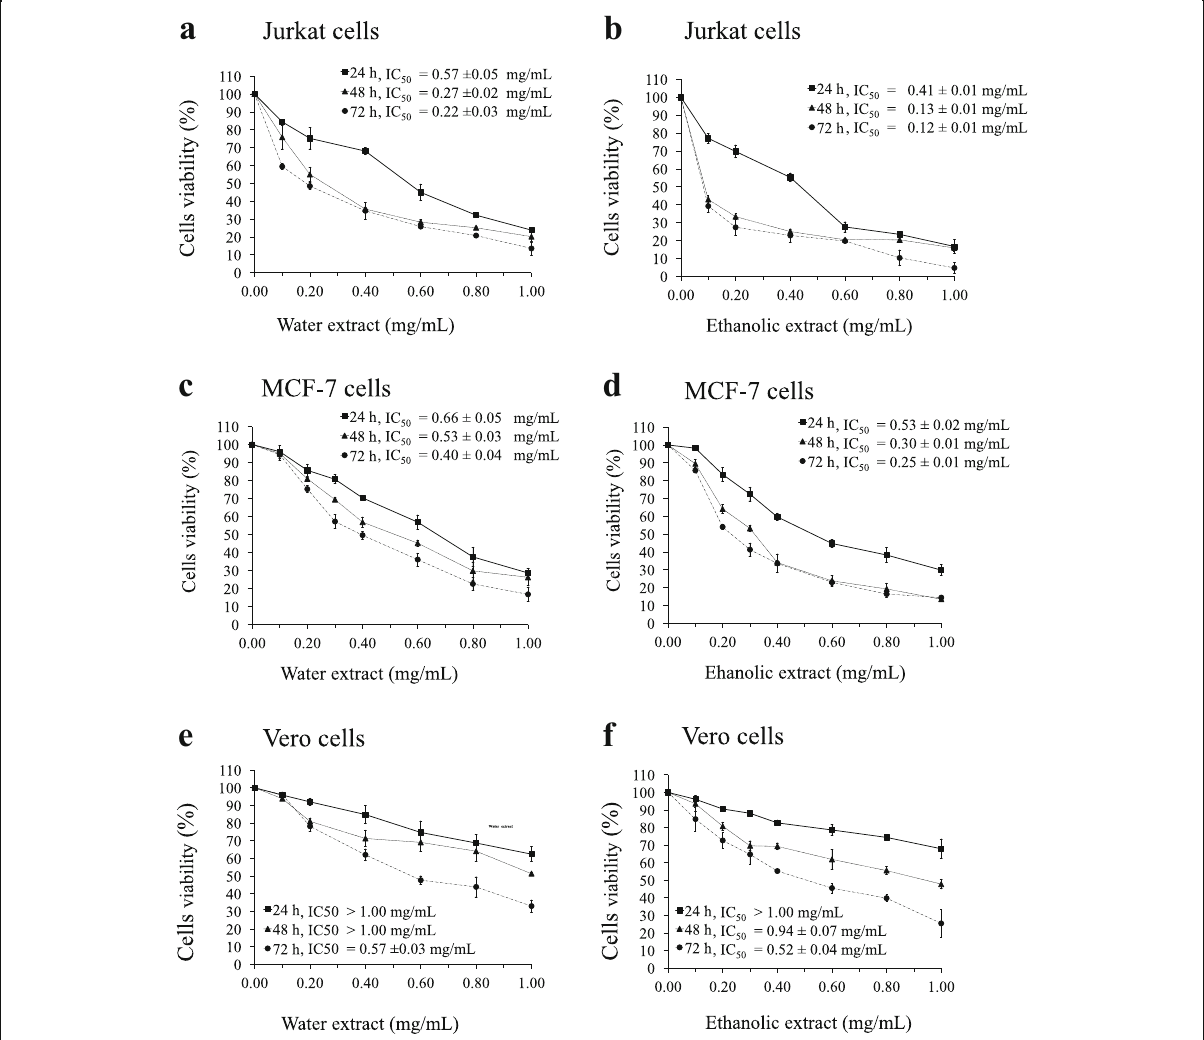
Fig. 2 Effect of water and ethanolic extracts prepared from the powdered formula of H. cordata fermented broth and P. emblica fruit on cell proliferation of Jurkat ( a , b ), MCF7 ( c , d ) and Vero ( e , f ) cells, treated for 24, 48 and 72 h. The cell viability was calculated by comparison with the control, 0.5% DMSO treated. The results were shown as mean ± S.D. ( n = 6). The average of half maximal inhibitory concentration (IC 50 ) values calculated from 3 independent experiments was presented along with a line